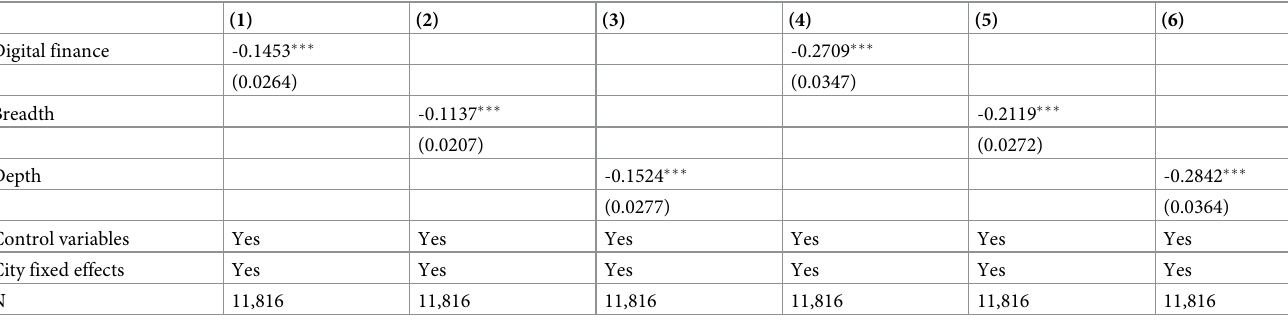
Table 18. Robustness checks by redefining relative